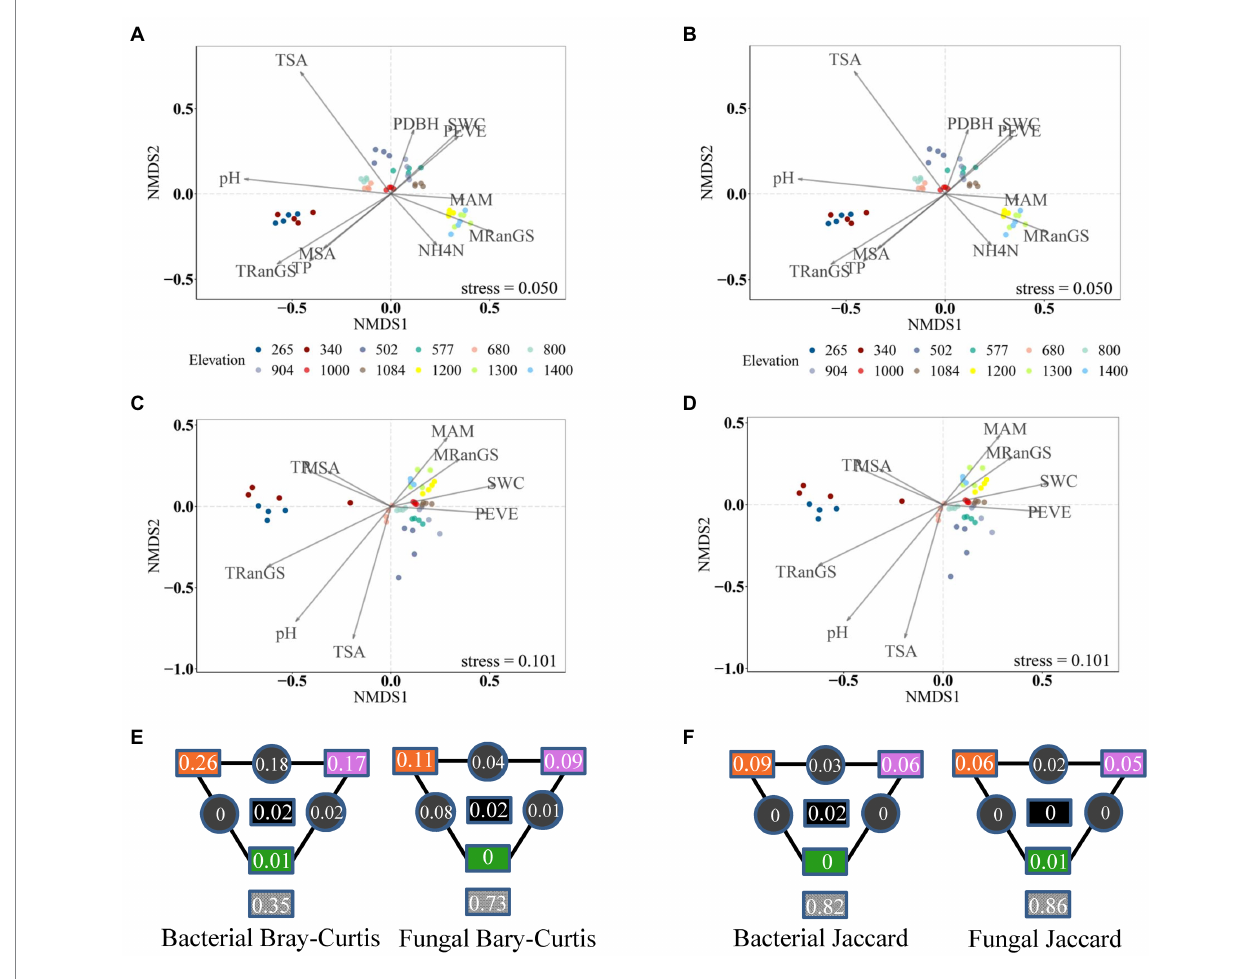
FIGURE 4 Non-metric multidimensional scaling (NMDS) of compositional dissimilarity for bacteria (A,B) and (C,D) fungi using Bray-Curtis (A,C) and Jaccard (B,D) dissimilarity. Colors show the elevation of the soil sample. The strength of statistically significant ( p < 0.05) explanatory variables is shown with solid arrows. (E,F) Partitioning of bacterial and fungal variance in compositional dissimilarity among important soil climatic factors (orange), soil chemistry (purple), vegetation (green), and their interactions (black). The values in gray squares are unexplained